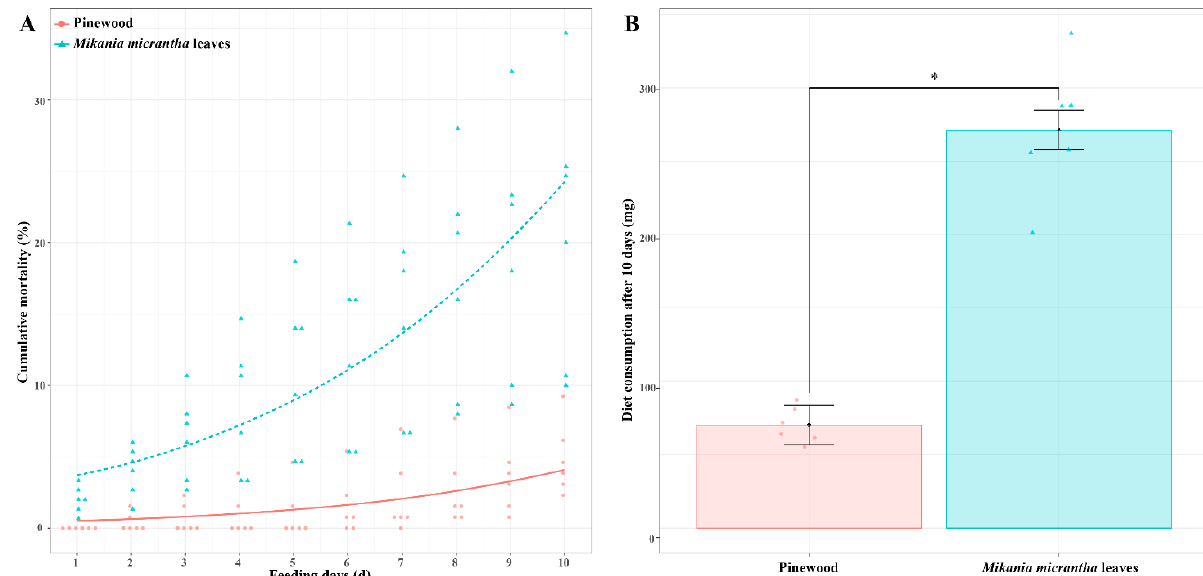
Figure 1. Termite cumulative mortality ( A ) and dry weight consumption of diets ( B ) after C. formosanus workers were fed a M. micrantha leaves or pinewood diet for 10 days. Red and blue dots represent the original data of each replicate from termites fed a pinewood diet and a M. micrantha leaves diet, respectively ( n = 6). Error bars represent standard deviations; asterisk indicates p < 0.05.